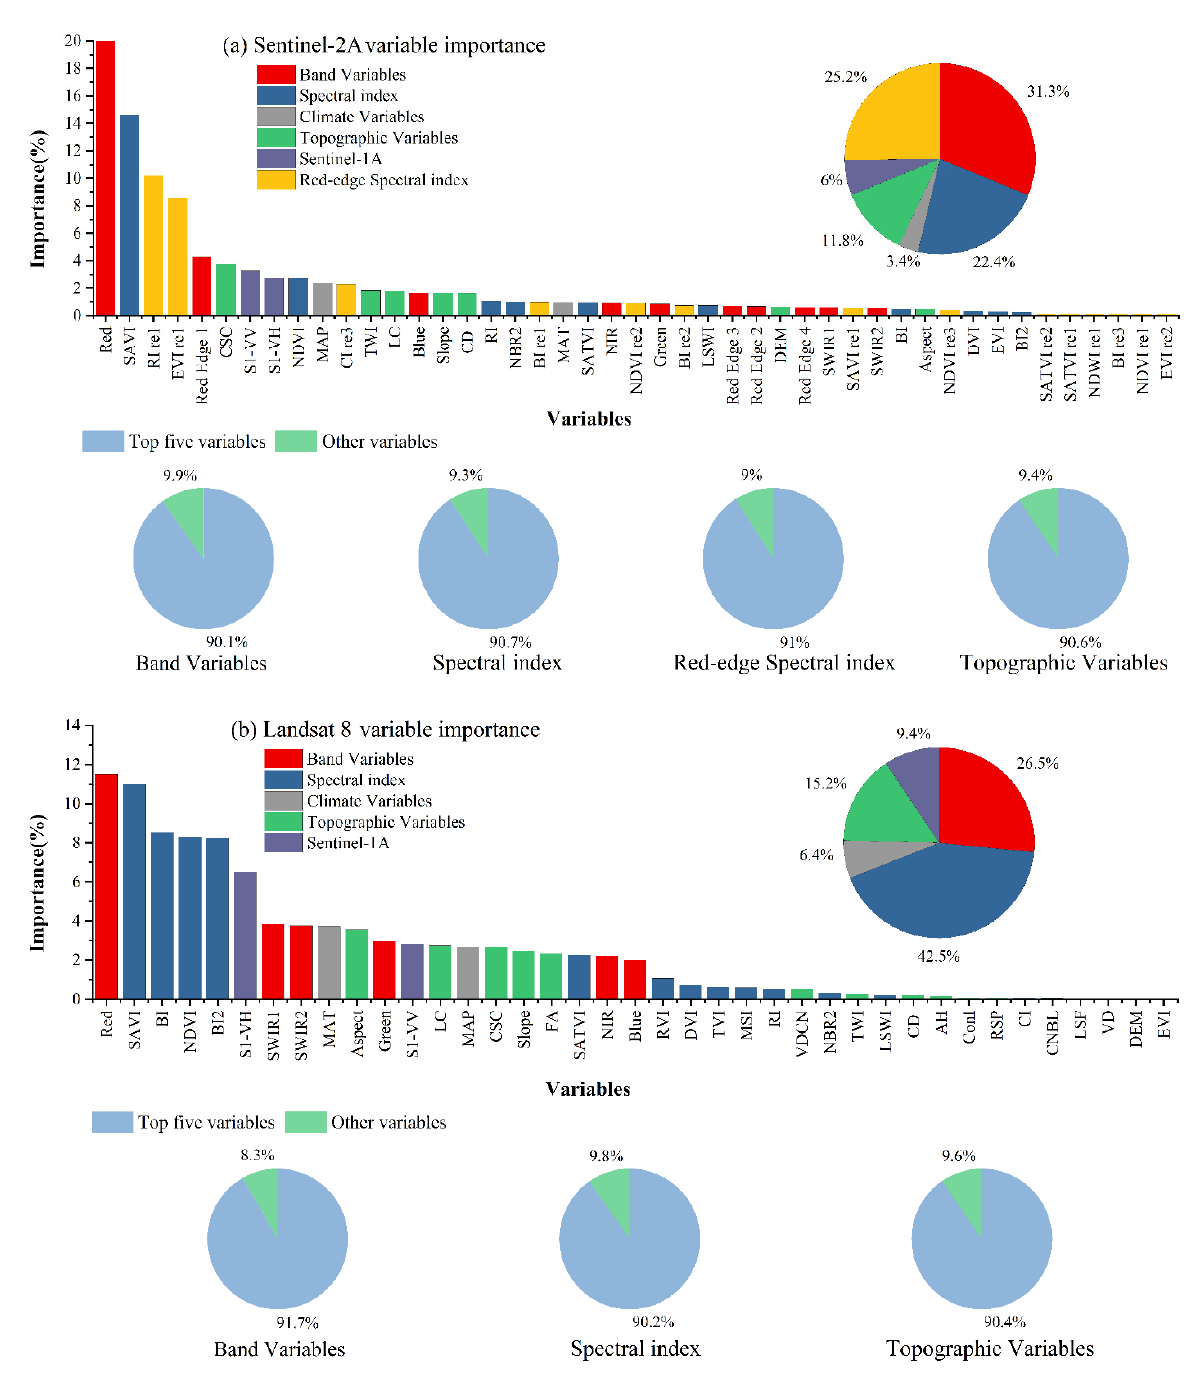
Figure 2. ( a ) Importance of variables in the Landsat 8 model; ( b ) importance of variables in the Sentinel-2A